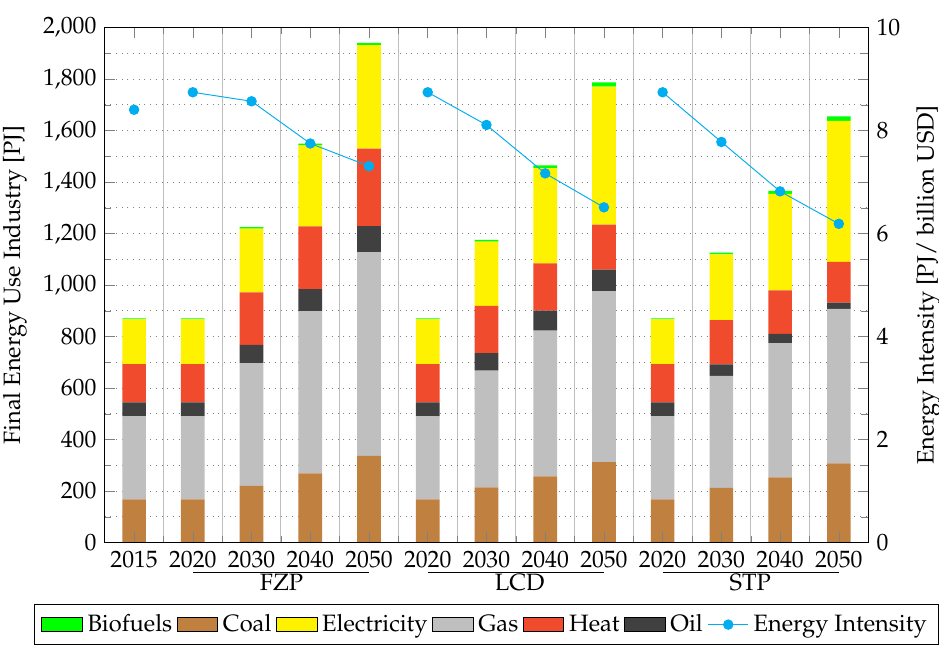
Figure 6. Final energy use in industry by fuel type for three main scenarios. The energy intensity, as an indicator for energy efficiency of the industry, as well as 300 the composition of the industry will decline in all scenarios. The indicator describes the 301 final energy use per USD of GDP from the industry sector. The lowest energy intensity 302 is reached in the STP scenario, which is slightly lower than the one of LCD. 303